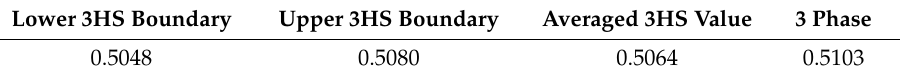
Table 12. Three-phase thermal conductivity approximations—cement system D. Lower 3HS Boundary Upper 3HS Boundary Averaged 3HS Value 3 Phase 0.5048 0.5080 0.5064 0.5103